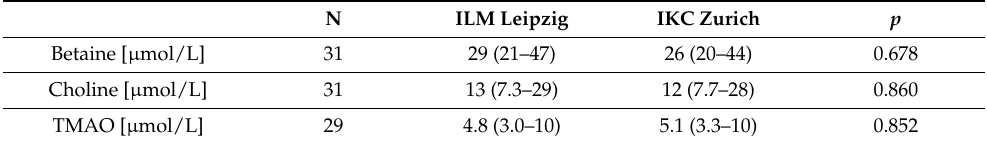
Table 3. Base data of inter-laboratory comparison given as median (IQR). Significance levels were calculated using Mann-Whitney U-Test.